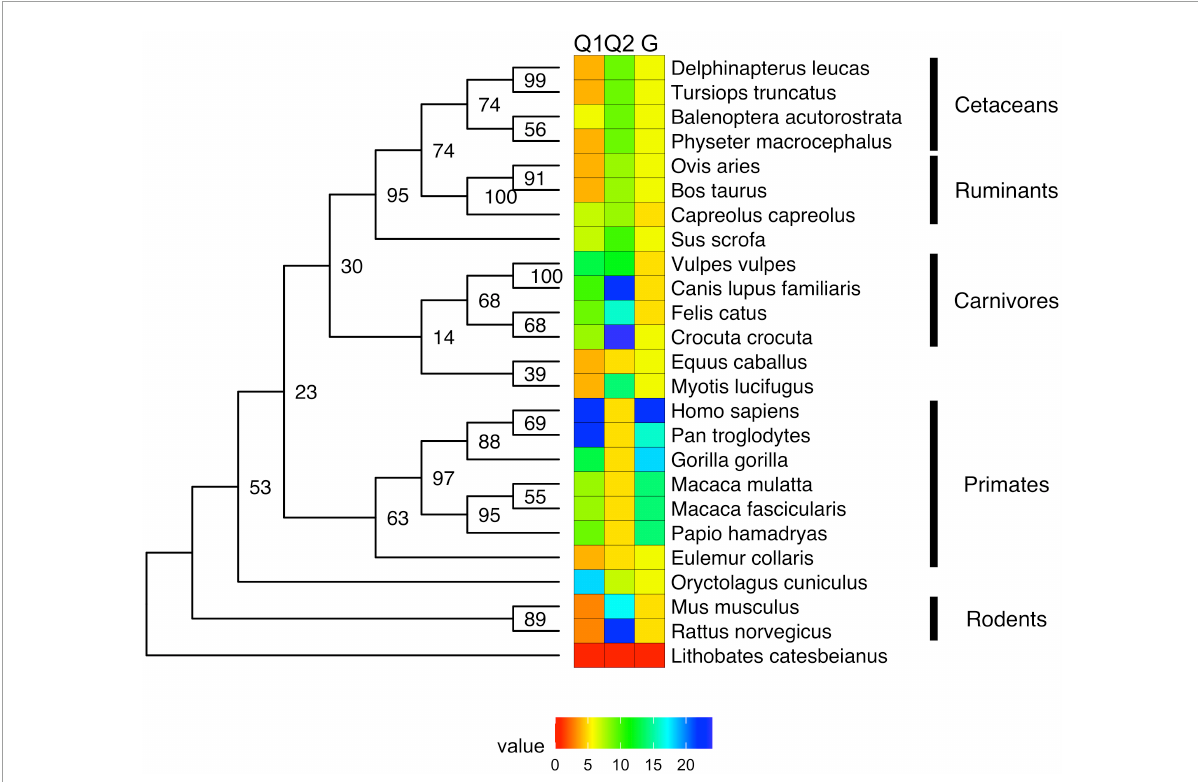
FIGURE2 Maximum likelihood (ML) phylogenetic tree of androgen receptor with heat map showing the length of the polyQ and polyG repeats. The ML phylogenetic tree (here shown as a cladogram) is displayed for the full-length UniProt sequences of AR (33). Sequences were aligned by MAFFT (159) and refined by RAxML (160, 161), and numeric values on the tree of the aligned AR sequences (159) indicate bootstrap percentages from 2000 iterations (160, 161) that can be regarded as a confidence score of local tree